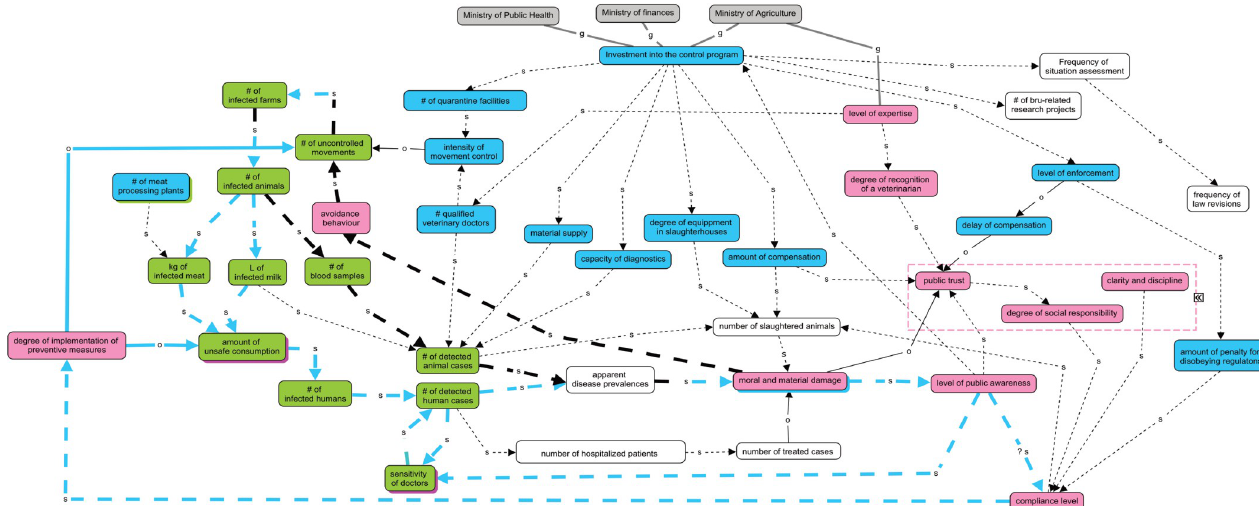
Fig 2. Map of the Kazakh system for brucellosis control. The boxes represent governing systems (grey), components affiliated with environmental domain (green), the economic domain (blue) and the social domain (pink). Shadows around elements indicate their affiliation to a secondary domain. Causal relationships are represented with black arrows where “s” stands for the change in the same direction (dashed line) and “o” (solid line) for the opposite direction. Grey lines with letter “g” represent governance links. Loops: a balancing loop (blue) reduces the “amount of unsafe consumption” and “uncontrolled animal movements” via “public awareness” and “compliance”. A reinforcing loop (bold black) raises the “number of infected animals” via “avoidance behaviour” and “uncontrolled movements”. If limited resources need to be allocated, the relative strength of these loops will determine the disease prevalence.